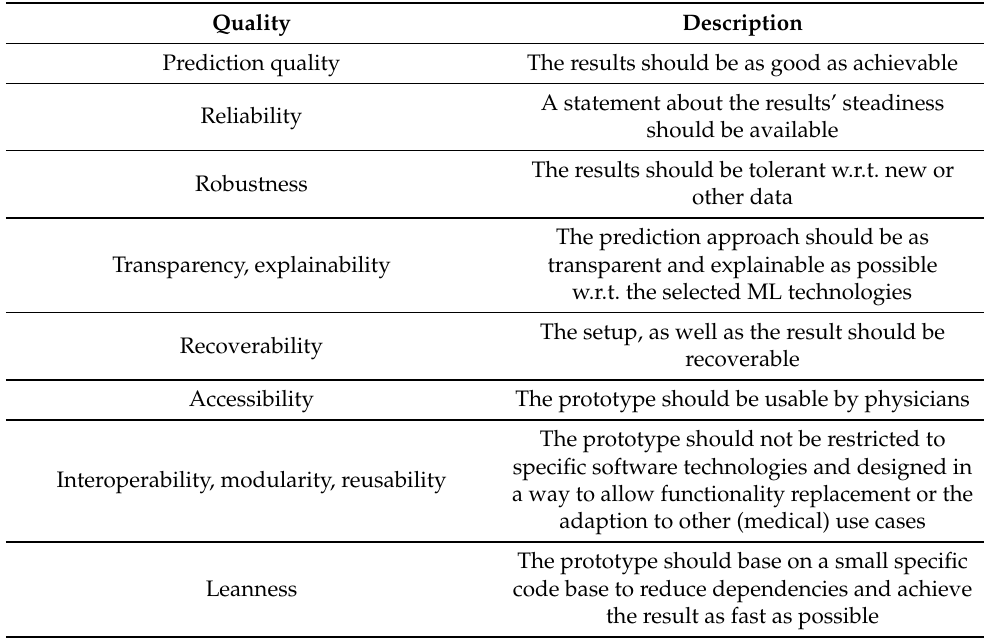
Table 1. Aspired software qualities for ML prototype; ML = Machine